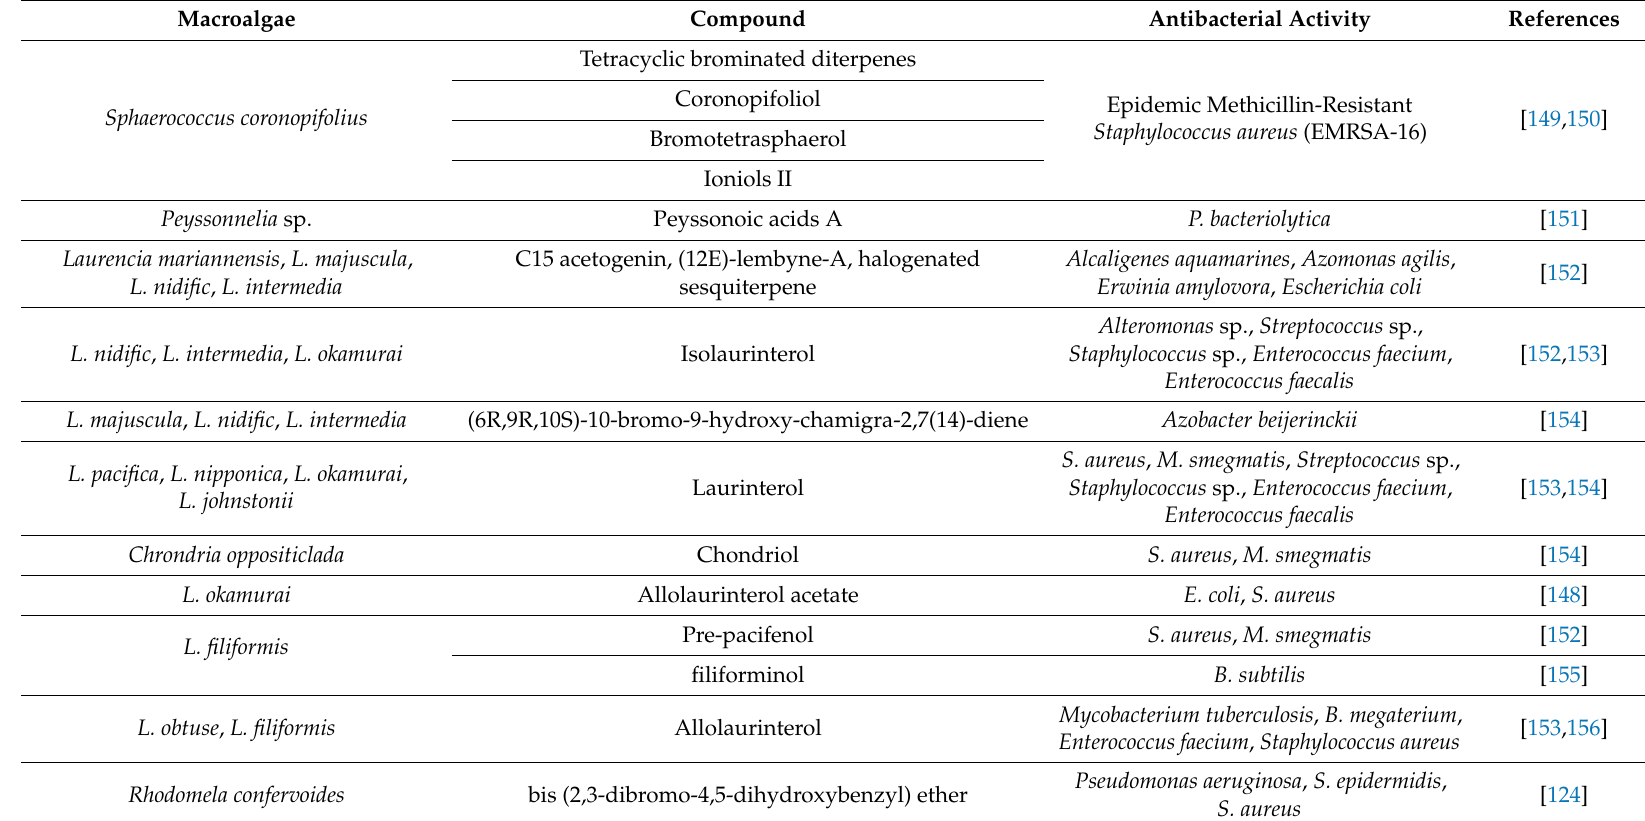
Table 2. Antibacterial activities of compounds isolated from